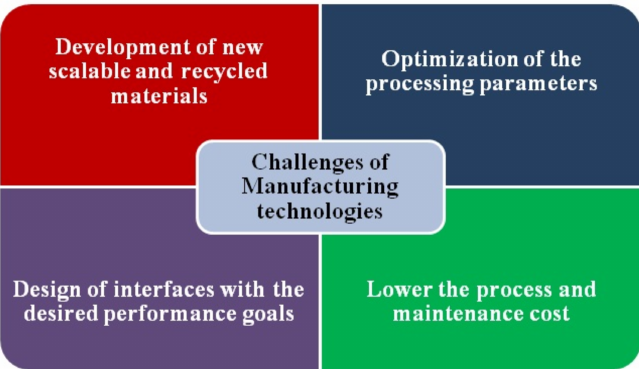
Figure 7. Main challenges encountered in the commercialisation of